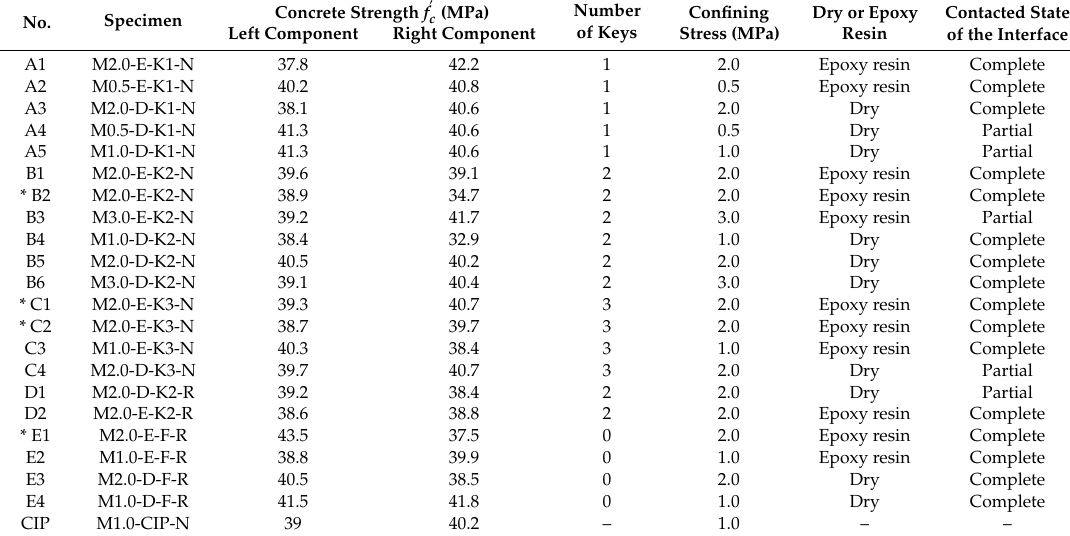
Table 1. Test information matrix of push-o ff tested specimens. M, monotonic loading; E, epoxied; K, key joint; D, dry; F flat joint; CIP,